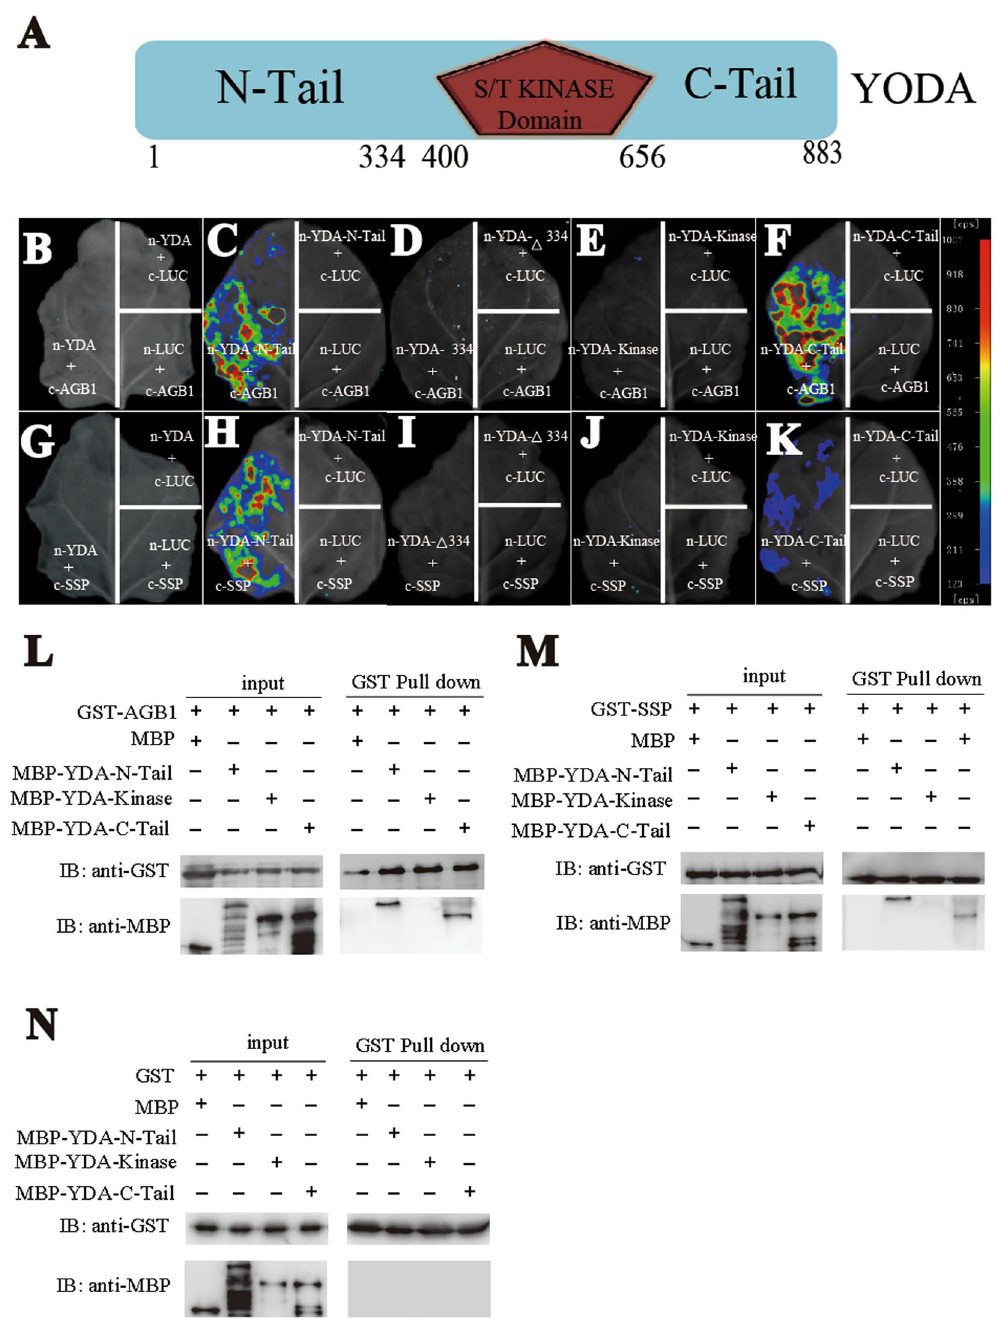
Figure 4. AGB1 and SSP physically interact with the N- and C-termial of YODA by luciferase complementation assay and pull-down assay. ( A ) Protein structure of YODA. N-Tail, kinase, C-Tail and Δ 334 (334–883aa) are indicated in the diagram. ( B – F ) Tobacco leaves co-infiltrated with agrobacterium containing 35S -driven construct pairs as indicated were photographed with a charge-coupled device camera. ( B – F ) cLUC-AGB1 interacts with nLUC-YDA-N-Tail ( C ) and nLUC-YDA-C-Tail ( F ), but not nLUC-YDA ( B ), nLUC- YDA- Kinase ( E ) or nLUC-YDA- Δ 334 ( D ), respectively. ( G – K ) cLUC-SSP interacts with nLUC-YDA-N-Tail ( H ) and nLUC-YDA-C-Tail ( K ), but not nLUC-YDA ( G ), nLUC-YDA-Kinase ( J ) or nLUC-YDA- Δ 334 ( I ), respectively. The pseudocolor bar shows the relative range of luminescence intensity in images. Pull-down assay shows that AGB1 ( L ) and SSP ( M ) interact with the N-Tail and C-Tail of YODA, but not the kinase domain. GST does not interact with the N-Tail, kinase domain or C-Tail of YODA ( N ). Full blots are shown in Supplemental